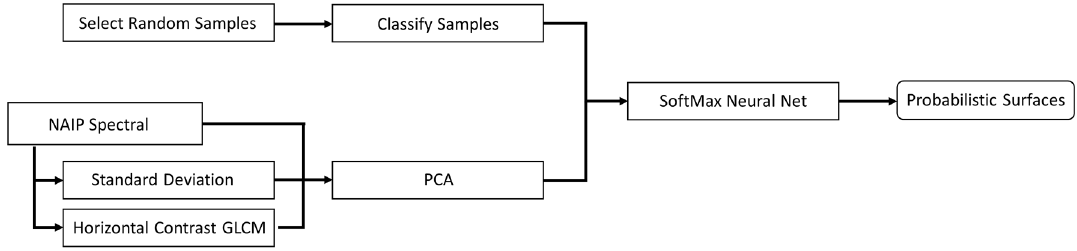
Figure 3. Flowchart of our classification methodology.